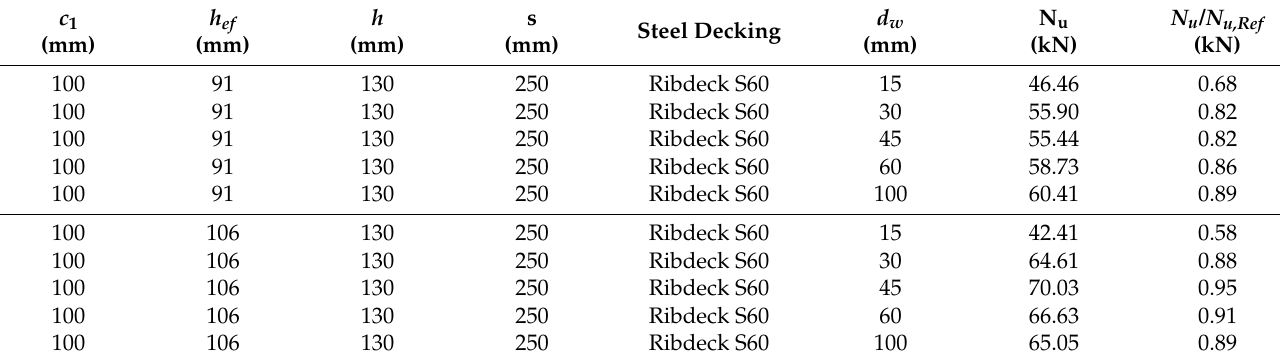
Table A3. Numerical results—Series 2 ( f c = 20 N/mm 2